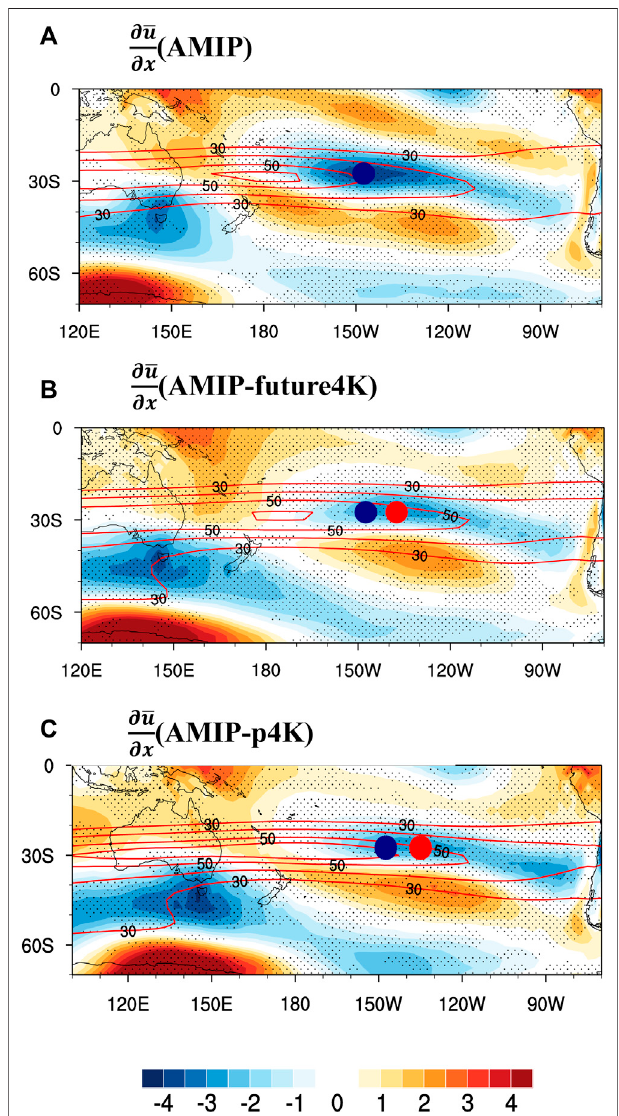
FIGURE 4 | JJA climatology of the zonal wind (contour lines; m/s) and the MME of z (cid:1) u z (shading; s − 1 ) in (A) AMIP, (B) AMIP-future4K, and (C) AMIP- x p4K. The dots indicate thatmore than 70% ofmodels agree on the signof the MME. The navy solid circle denotes the central longitude of z (cid:1) u z latitudes in AMIP, and the red circle in (B , C) denotes the central longitudes of z (cid:1) u z x in the mid-latitudes in AMIP-future4K and AMIP-p4K, respectively.